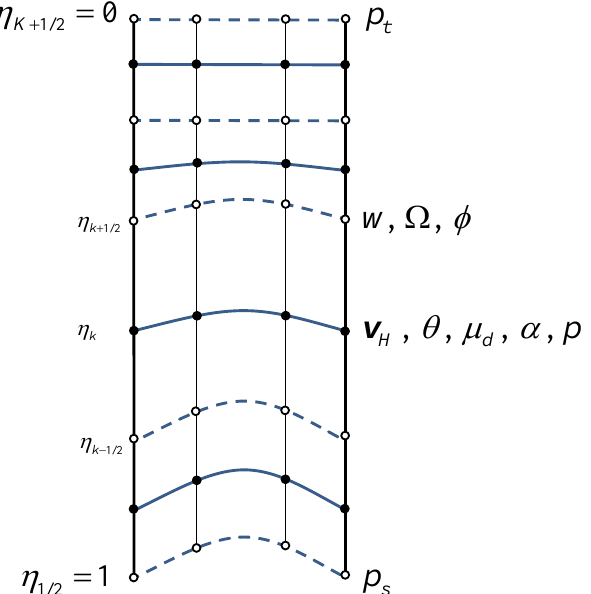
Figure 1. Grid points of columns within an element having four GLL points. The hybrid sigma–pressure coordinates are illustrated, and the closed (open) circles on the solid (dashed) line indicate the location of the variables at layer midpoints